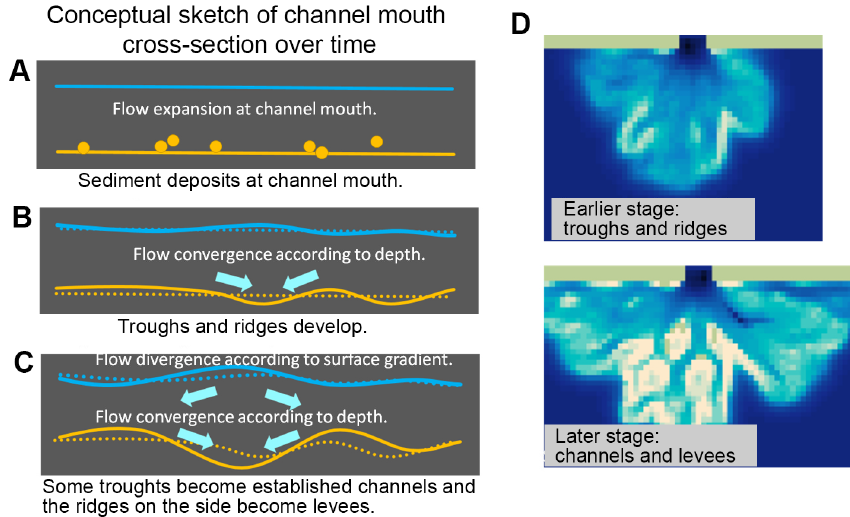
Figure 17. Illustration of the mechanics of bifurcation formation in the DeltaRCM: (a) flow expands and sediment deposits with reduced flow velocity, which creates a wide lunate bar with noisy surface; (b) the irregular topography of the bar forms “ridges” and “troughs” where troughs attract more water flux than ridges, the enhanced flow rate in troughs prevents sediment from settling while ridges continue to experience deposition; (c) the process reaches equilibrium by a feedback mechanism between water surface elevation and water flux. The few paths established from the troughs outcompete the others. (d) A sample simulation from DeltaRCM shows two stages of the conceptual processes described above: the earlier stage with troughs and ridges, and the later stage with channels and